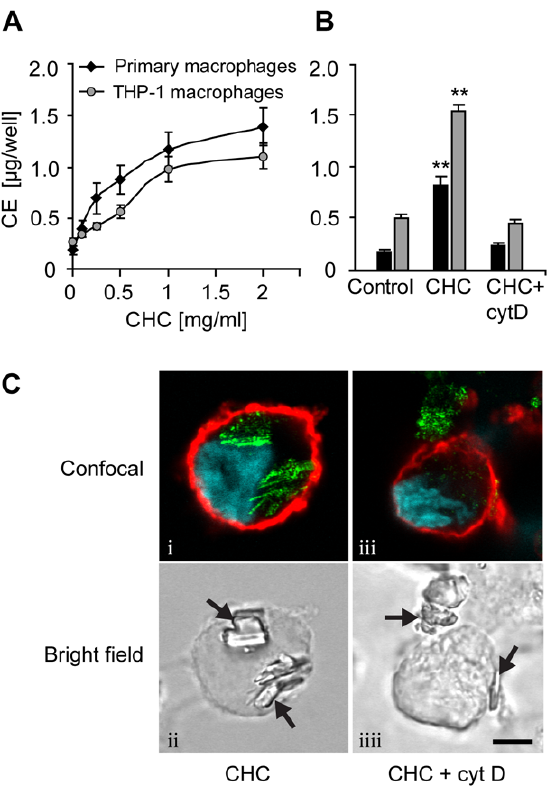
Figure 1. Macrophages accumulate cholesteryl esters when incubated with cholesterol crystals (CHCs). (A) Primary macro- phages and THP-1 macrophages were incubated with 0.1–2 mg/ml CHCs and cholesteryl esters (CE) were measured from cellular lipid extracts by TLC. (B) Cytochalasin D (cytD; 2 m M) was employed to block cytoskeletal movements during a 16 h incubation of primary and THP-1 macrophages with CHCs (0.5 and 1.0 mg/ml, respectively). (C) THP-1 macrophages treated with CHCs 6 cytD were stained with fluorophore- conjugated cholera toxin subunit B (cell membrane; red) and Hoechst (nuclei; blue). The cells were imaged using confocal fluorescence microscopy, combined with detection of CHCs by confocal reflection of the 488 nm laser line (green) (panels i, iii). CHCs are indicated by arrows in the bright field panels (ii, iiii). Scale bar 5 m m. Each experiment was performed $ 4 times. The data are means 6 s.e.m. **=p , 0.01, compared to the control cells.